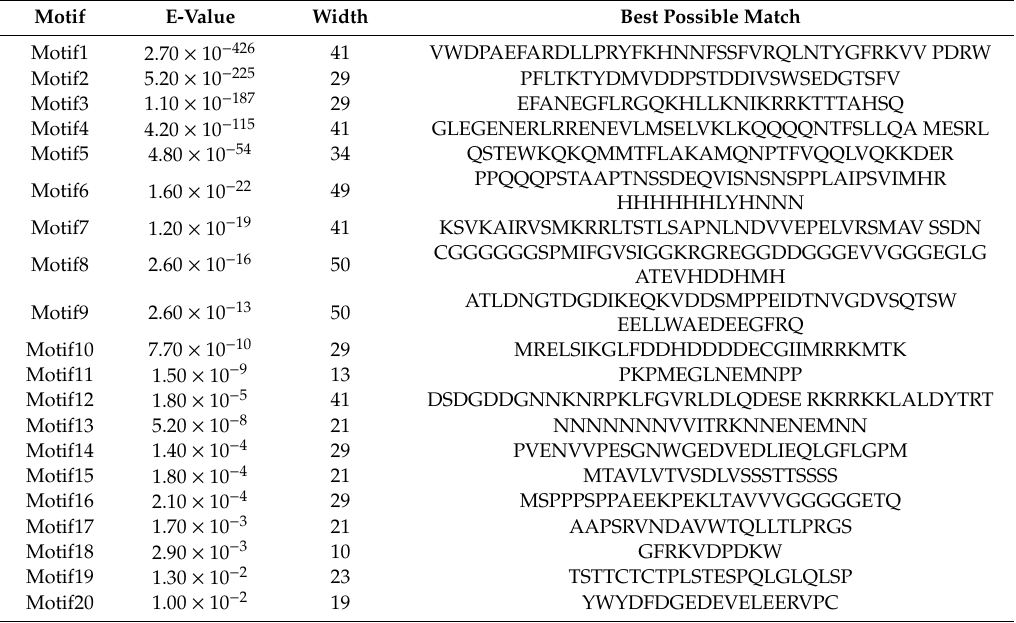
Table 2. Analysis and distribution of conserved motifs in carnation